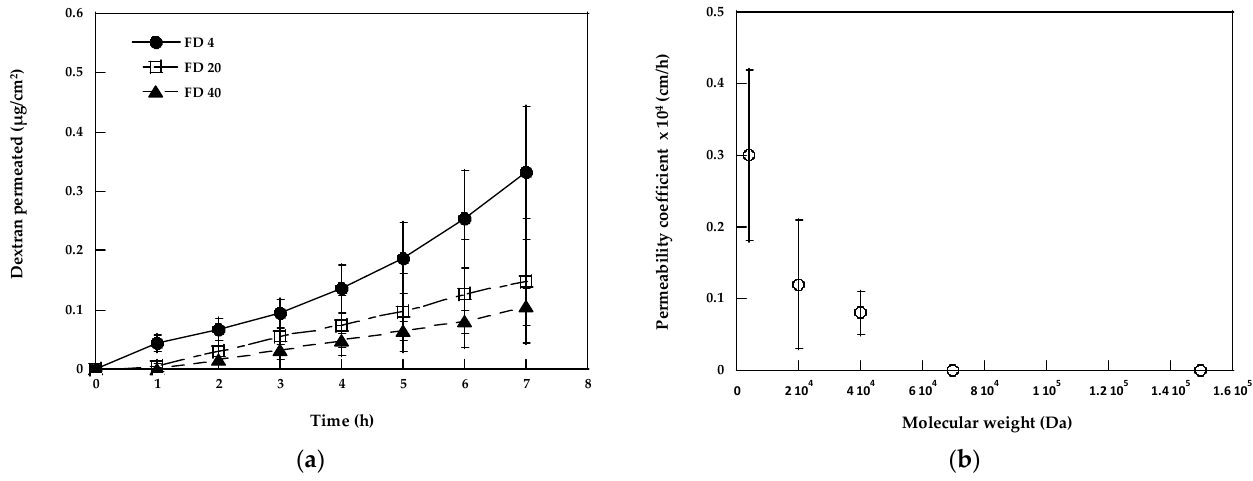
Figure 1. ( a ) Passive permeation profiles of dextrans from 2 mg/mL solutions in the PBS pH 7.4. The amounts of FD-70 and of FD-150 found in the receptor compartment were below the limit of quantification of the analytical method. ( b ) Permeability coefficient of dextrans as a function of molecular weight. Mean values ± SEM ( n = 5–7). Table 1. Permeation parameters of dextran across the pig esophageal epithelium (mean values ± SEM) using fatty acids and bile salts as penetration